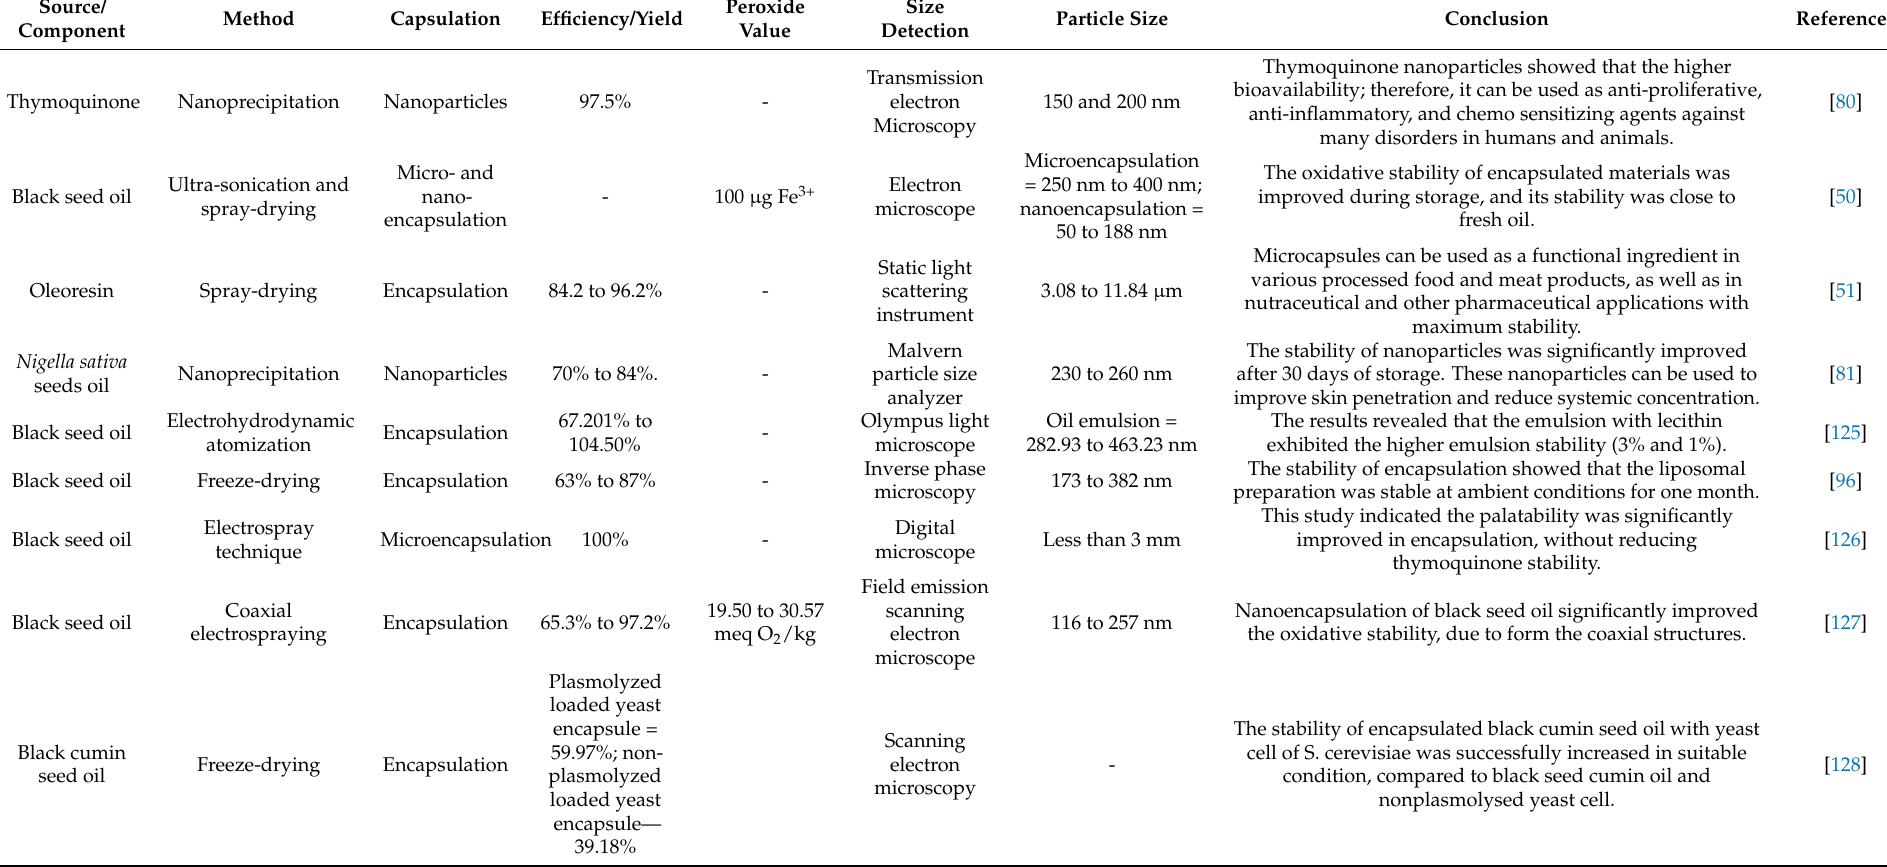
Table 3. Technologies use to enhance the oxidative stability of black seed oil and their